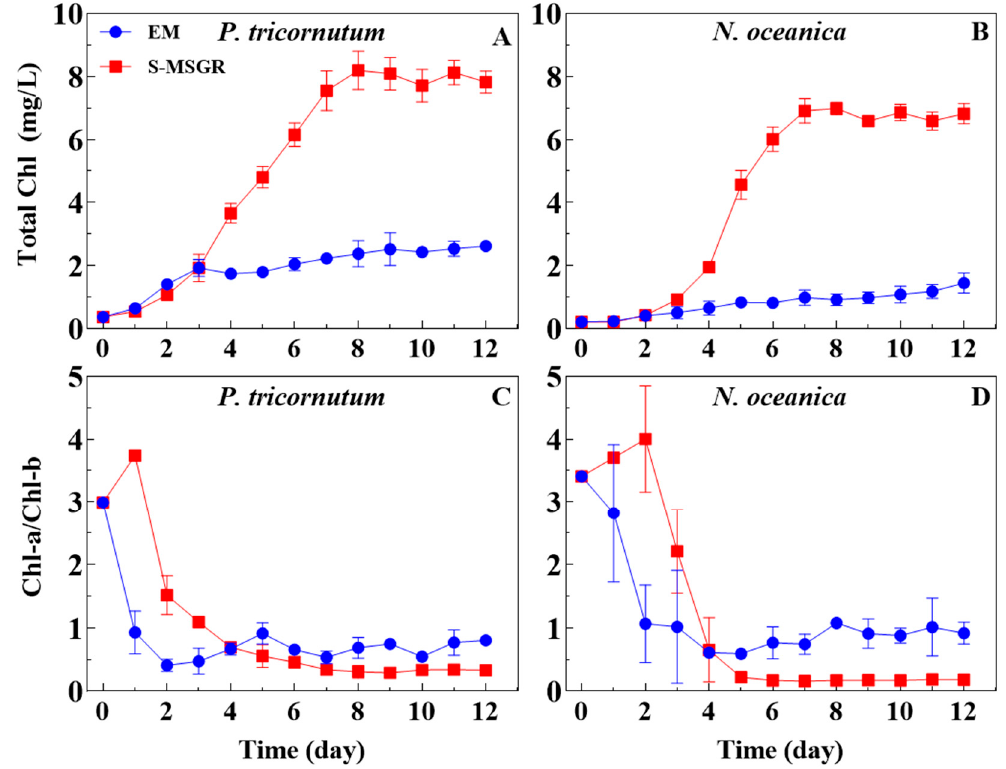
Figure 3. Changes in total chlorophyll content ( A and B ) and ratios of Chl-a/Chl-b ( C and D ) of the two marine microalgae, P. tricornutum and N. oceanica , grown in EM and in S-MSGR. Values are expressed as means ± s.d. ( n = 3).